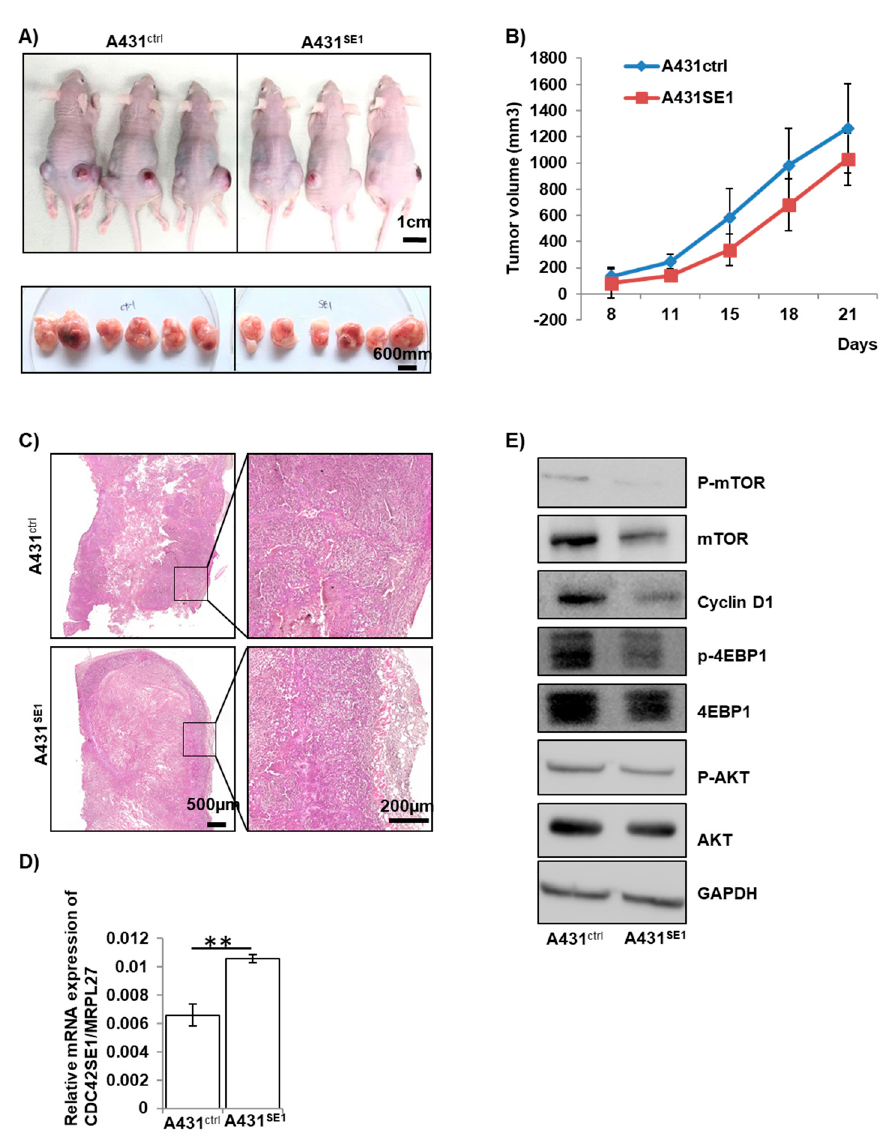
Figure 7. CDC42SE1 suppresses growth of A431-derived tumors in-vivo. ( A , B ) A431 Ctrl and A431 SE1 cells (1 × 10 6 cells) with 50% of matrigel were injected subcutaneously into nude mice (n = 6 for each group). The mice were photographed every two days and the image shown is of mice 21days after the injection. The tumor size was measured by Vernier caliper at 8th, 11th, 15th 18th, and 21st day after injection of A431cells into nude mice, and the tumor volume was calculated using L X W 2 /2 formula. Data points represent mean tumor volumes. ( C ) Tissue sections from mice injected with A431 SE1 and A431 Ctrl cells were prepared and stained with H & E. H & E staining image showed that the tumors formed by A431 Ctrl cells were well organized and differentiated compared to tumors formed by A431 SE1 cells (n = 6). ( D ) Total RNA was isolated from A431 Ctrl and A431 SE1 tumor samples using Trizol, converted to cDNA, and used to perform qPCR with CDC42SE1 and MRPL27 specific primers. Relative abundance of CDC42SE1 was normalized against MRPL27 (n = 3). ( E ) Protein lysate from A431 SE1 and A431 Ctrl tumors were subjected to immunoblot analysis using antibodies against Akt, P-Akt, mTOR, P-mTOR, 4-EBP1, and cyclin D1. GAPDH was used as a loading control (n = 3). (** p ≤ 0.01, * p ≤ 0.05).